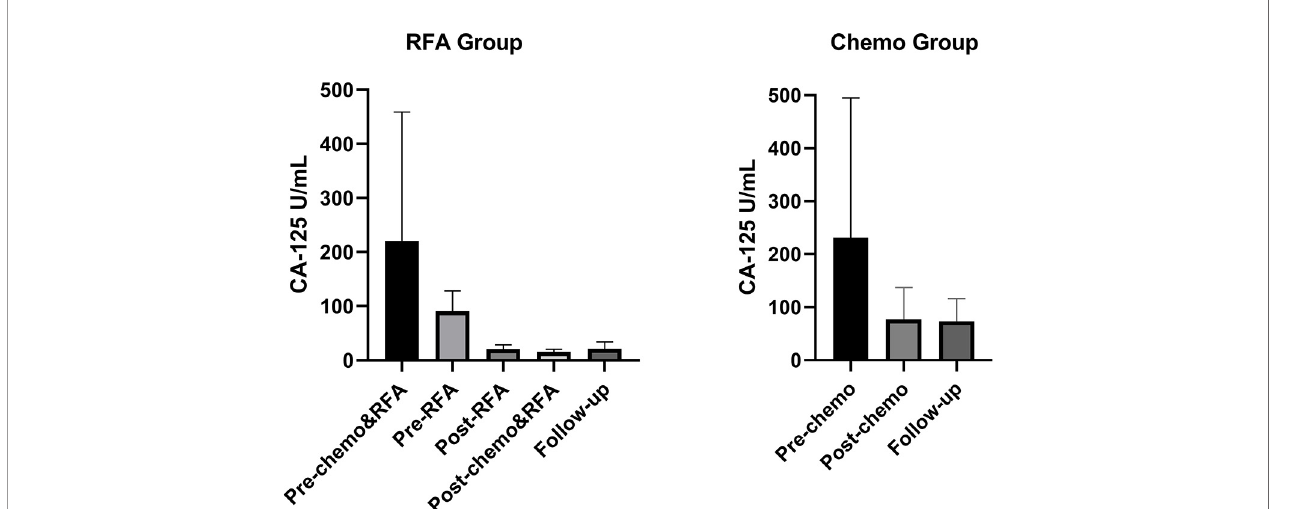
FIGURE 3 | Serum CA-125 levels for all patients during the treatment. For the RFA group, pre-chemo&RFA shows CA-125 levels before chemo and RFA treatment, pre-RFA shows CA-125 levels before RFA, post-RFA shows CA-125 levels after RFA and before the next cycle of chemo therapy, post-chemo&RFA shows CA-125 levels 30 days after chemo and RFA. For the control group, pre-chemo shows CA-125 levels before chemo therapy, post-chemo shows CA-125 levels 30days after chemo therapy.